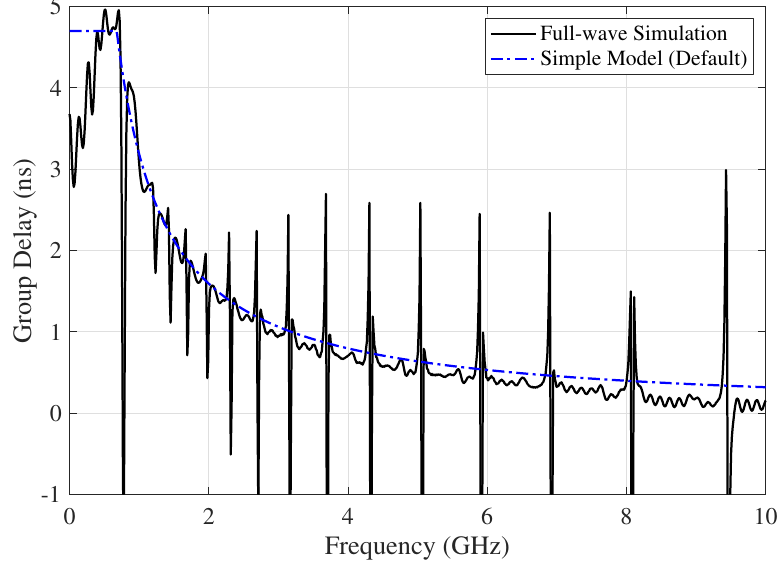
Figure 15. Full-wave simulation vs. simple model (default parameters with fixed delay cap d c ) of the group delay due to dispersion in the traditional sinuous antenna with